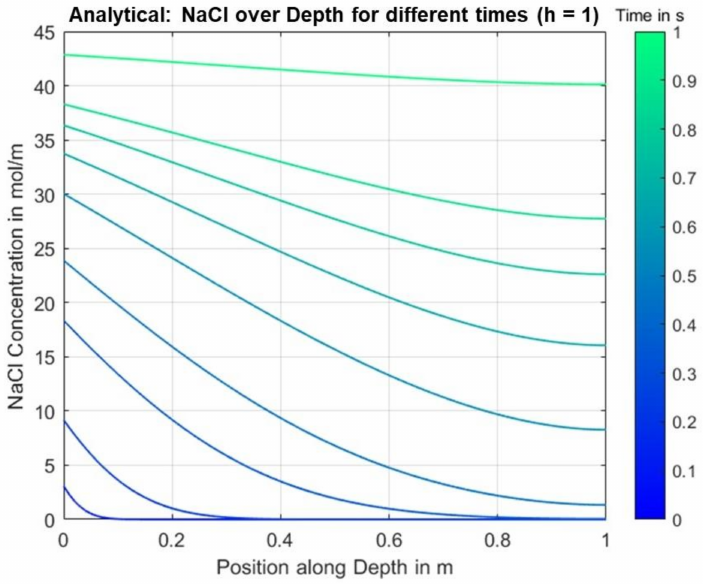
Figure 4. Analytical solution results for the concentration over position for different